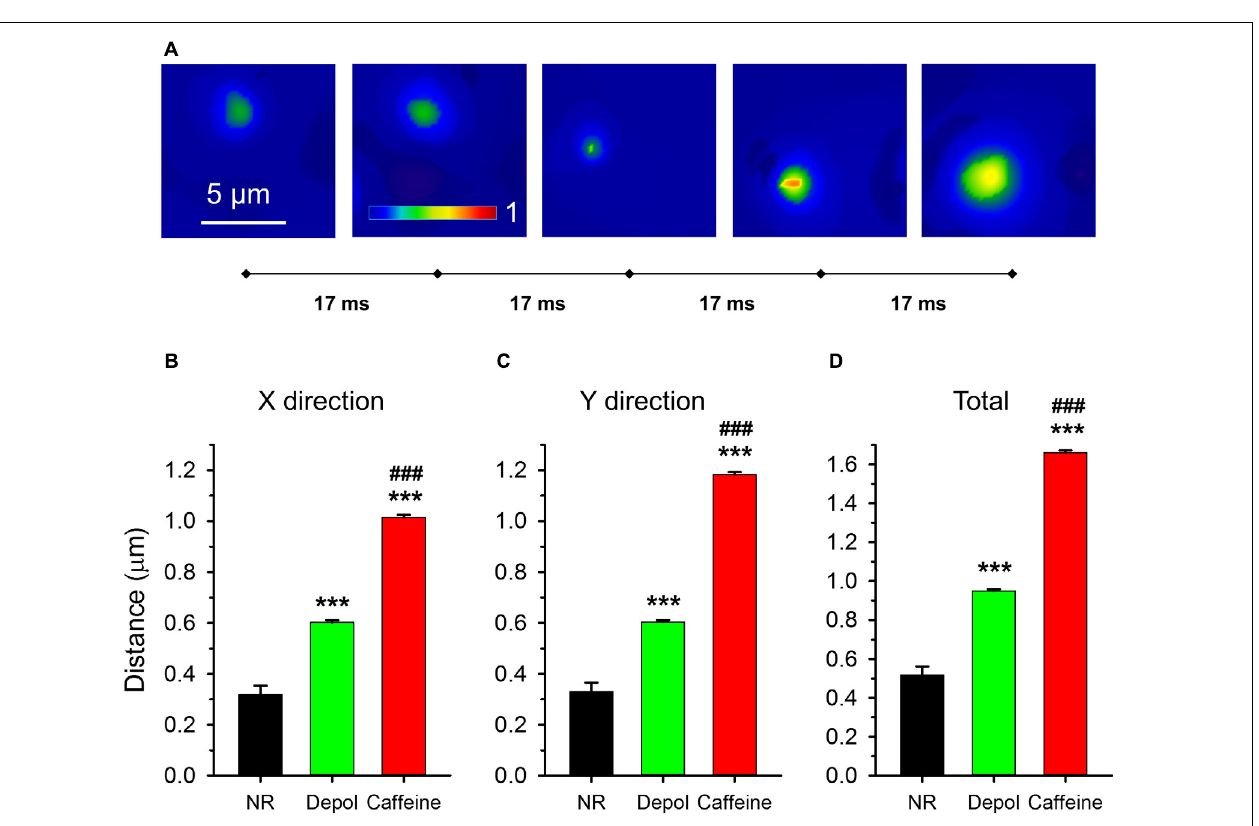
FIGURE 9 | Traveling events on consecutive x-y images. (A) Five consecutive F/F 0 images with the traveling sparks identified. The sampling rate was 17 ms/image (60 FPS). (B–D) Averages of distances traveled. (B,C) report distances in X and Y direction, respectively, while panel (D) presents the total distance traveled. The numbers of events analyzed are presented in Table 2